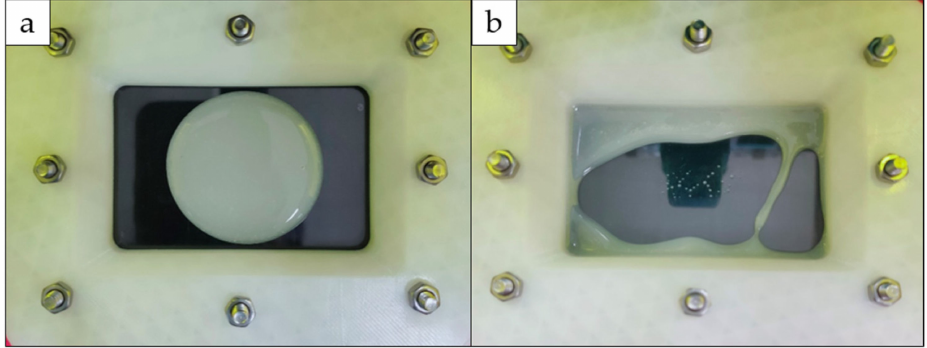
Figure 2. 13 wt.% of PHB/UDMA resin blends: ( a ) Before printing; ( b ) After printing. The exposure time of UDMA resin towards ultraviolet light also influenced the 3D printed structure. Commercialized resins have their own specific exposure rate time setting. As PHB powder was added to the resin, it also disrupted the actual exposure time